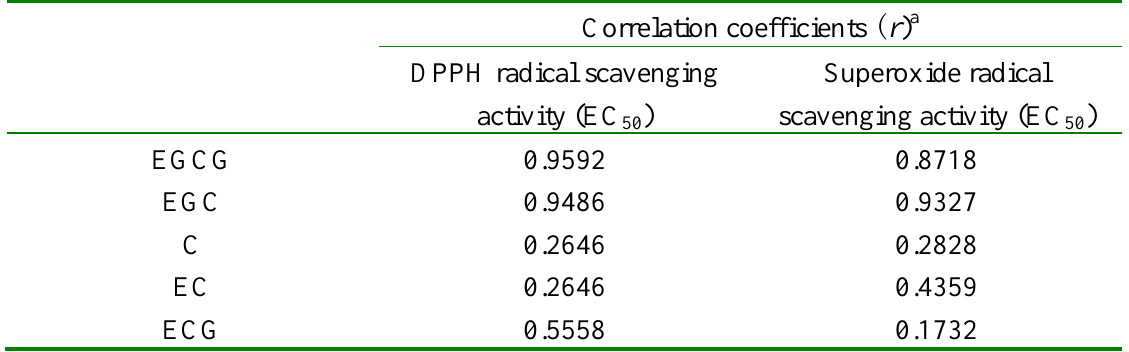
Table 3. Correlation coefficients between antioxidant activity and individual catechin of